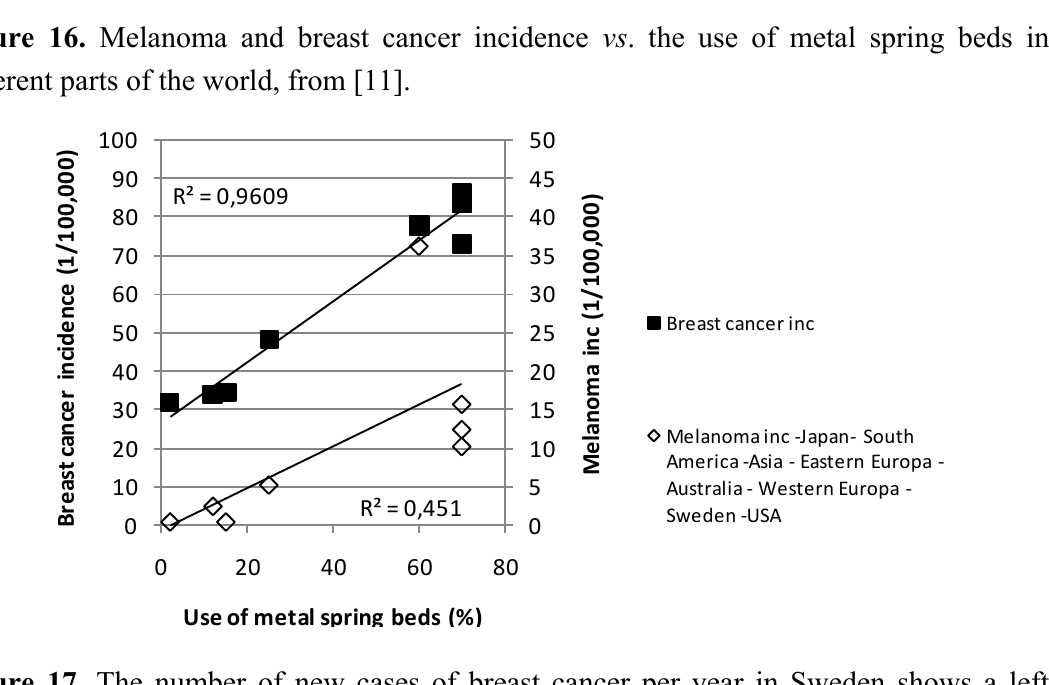
Figure 17. The number of new cases of breast cancer per year in Sweden shows a left dominance